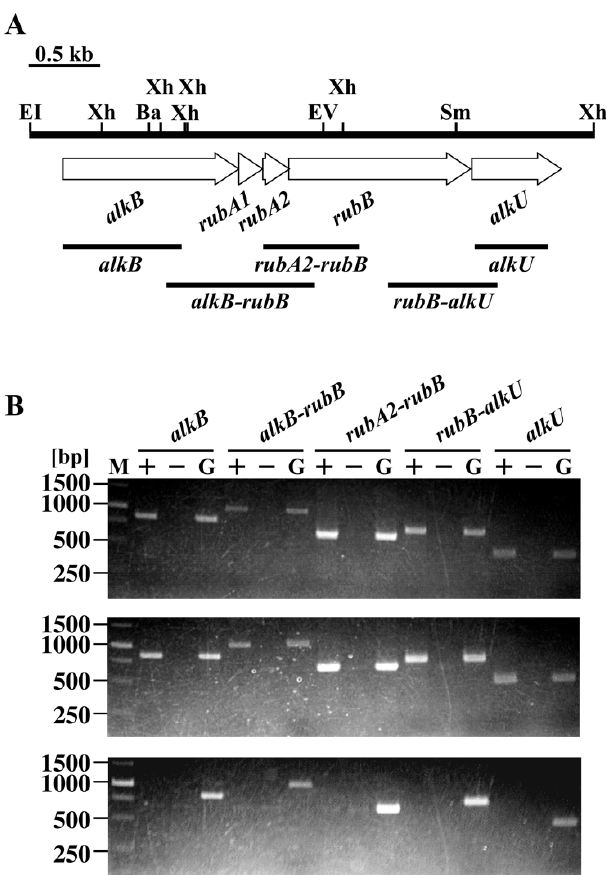
Figure 2. Organization and RT-PCR analysis of the alk gene cluster in RHA1. ( A ) Open arrows indicate the sizes, locations, and transcriptional directions of ORF. Boldfaced bars below the gene cluster diagram indicate the locations of the amplified RT-PCR products shown in panel B. Abbreviations for restriction enzymes: Ba, BamHI; EI, EcoRI; EV, EcoRV; Sm, SmaI; and Xh, XhoI. ( B ) Total RNA used for cDNA synthesis was isolated from RHA1 cells grown on n -undecane ( upper panel ), n -hexadecane (middle panel), and pyruvate ( lower panel ). Agarose gel electrophoresis of RT-PCR assays with primers targeting alkB (expected size, 831 bp), alkB - rubA1-rubA2-rubB (expected size, 1039 bp), rubA2-rubB (expected size, 671 bp), rubB-alkU (expected size, 766 bp), and alkU (expected size, 510 bp) are shown. Positions of amplified regions and primer sequences are indicated in panel A and Table 2, respectively. Lane M, molecular weight markers; Lanes + and − , RT-PCR with and without RT, respectively; lane G, control PCR with the RHA1 genomic DNA.